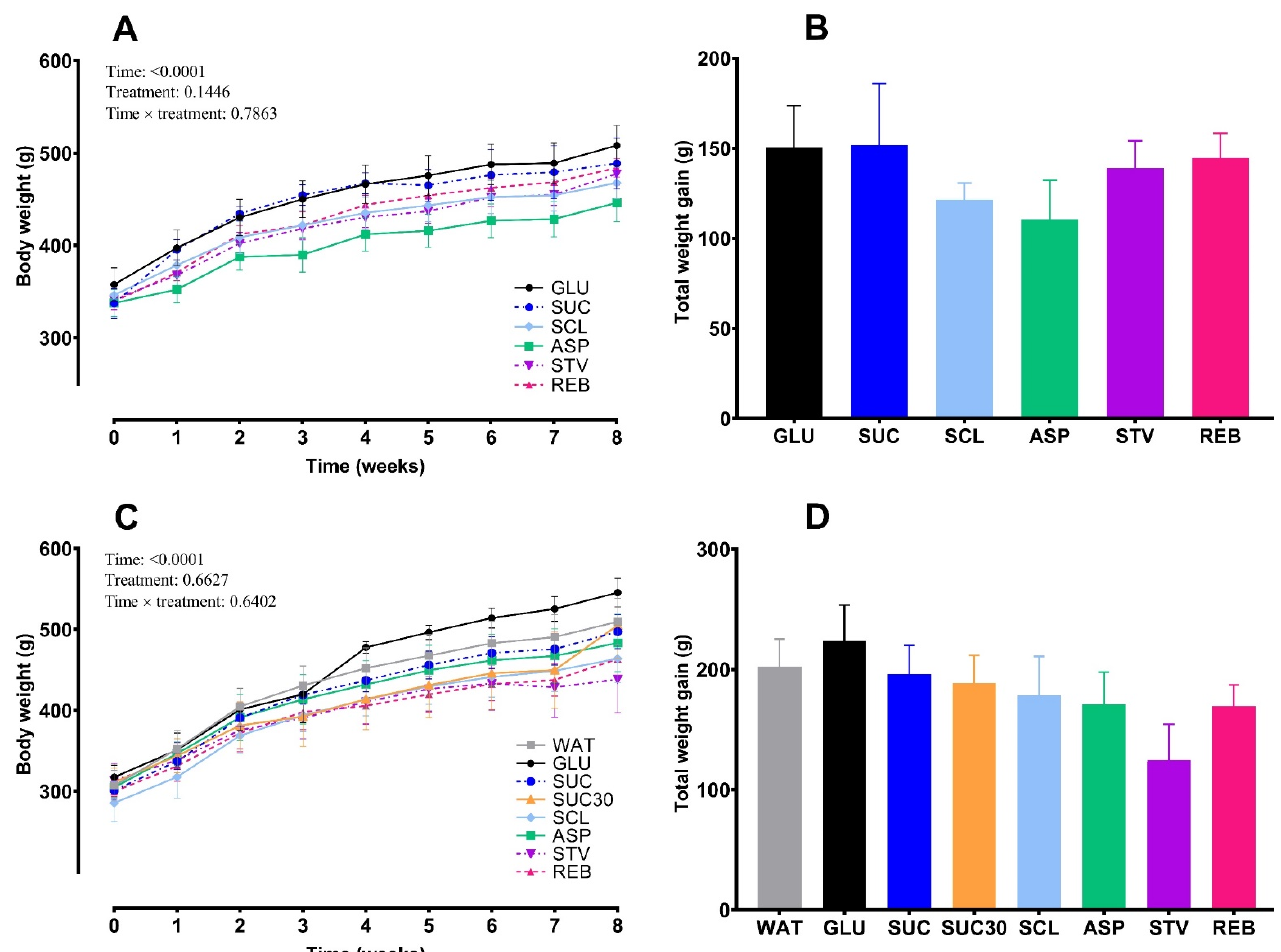
Figure 5. Effects of NNS on weekly body weight throughout 8 weeks of treatment and total weight gain in the ND group ( A , B ) and in the HFD group ( C , D ) (phase 2). Data are expressed as mean ± SEM. ( n = 6–8 animals per group). No significant differences among groups were observed after ANOVA on body weight evolution or total weight gain in ND and HFD. WAT, water; GLU, glucose; SUC, sucrose; SUC30, 30% sucrose; SCL, sucralose; ASP, aspartame; STV, stevia; REB, reb A.